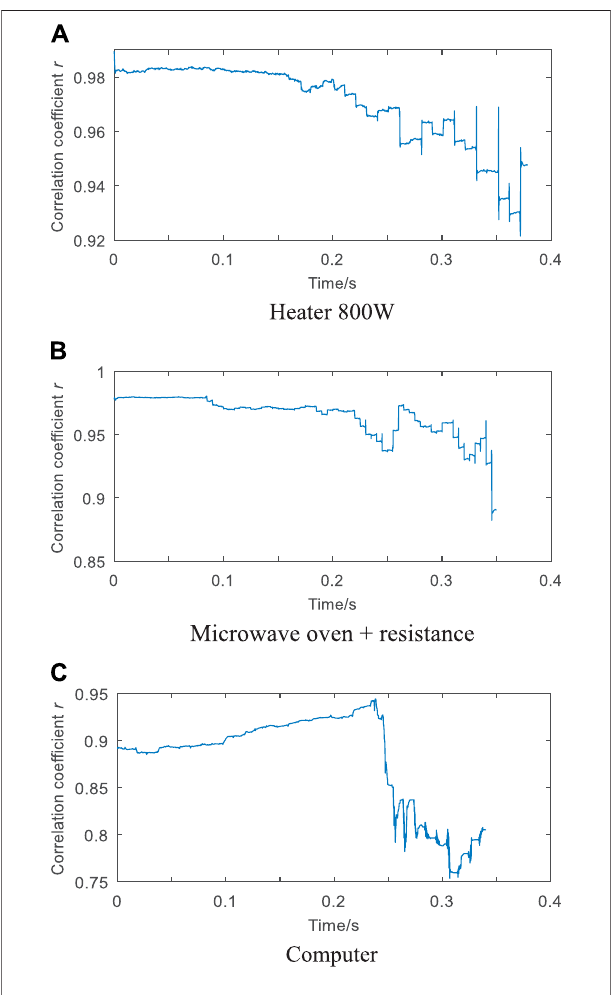
FIGURE 4 | Curve graph of correlation coef fi cient r after Pearson transformation. (A) Heater 800 W. (B) Microwave oven + resistance. (C) Computer.